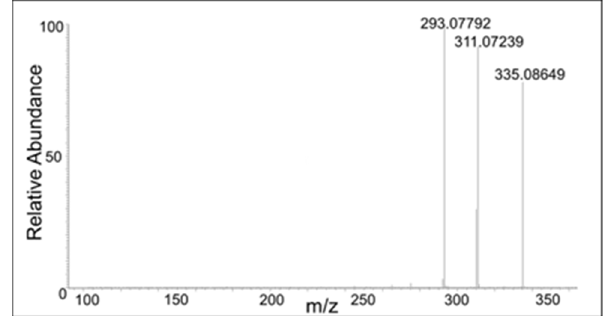
Figure 8. The CID mass spectrum of the m/z 353 mass unit ion eluting at 17 min.